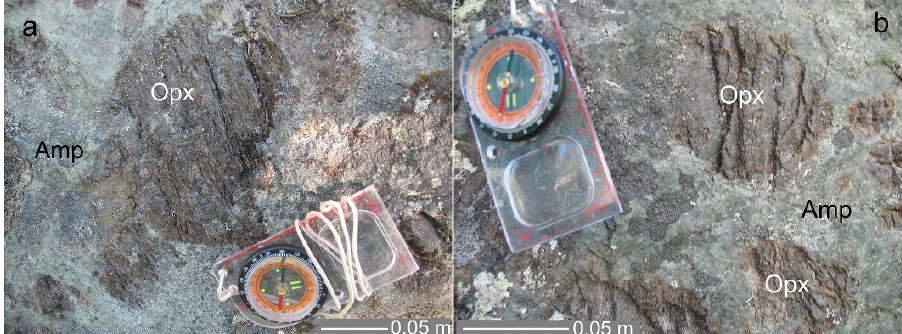
Figure 6. ( a , b ) Characteristic examples of megaspheroidal orthopyroxene (Opx), resorbed and converted to amphibole to various extents, as observed in pegmatitic facies at the southern contact of the Lyavaraka intrusion. The label Amp refers to amphibole.